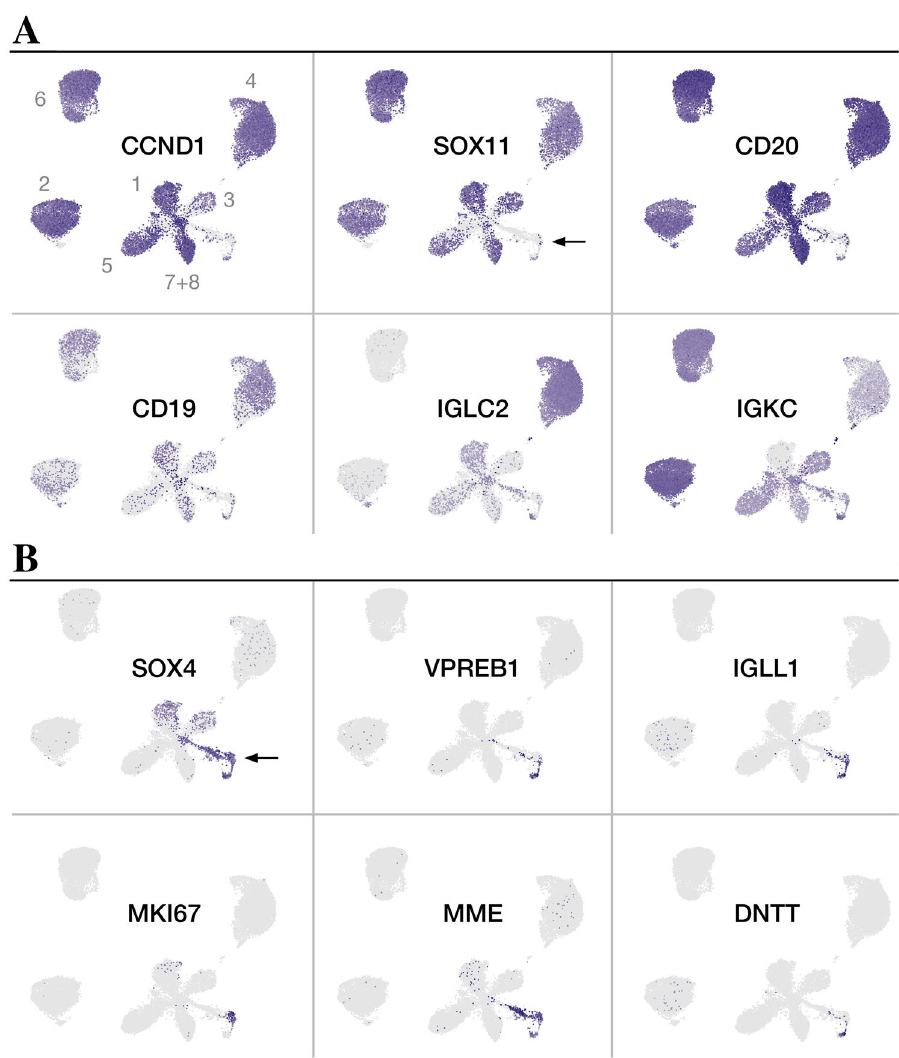
Figure 2. Global expression of molecular pathology markers frequently applied in diagnosis of mantle cell lymphoma ( A ) and markers associated with immature B cells ( B ) in combined mantle cell lymphoma (MCL) single cell transcriptomes. The resolved representations of cells from each MCL patient (pt.) were in general agreement with molecular pathology markers of MCL ( A ), although CD19 was only positive in a fraction of the single cells at the transcriptional level (12.2%). The dominating Ig κ and λ light chain restriction could be transcriptionally identified, with pt. 2, 3, 5, 6, 7, 8 being κ, and 1 and 4 being λ, the average double-positive was 7%, ranging from 0 (pt. 1) to 24% (pt. 4). CCND1 and CD20 were the most widely expressed molecular pathology markers. Markers of immature pre-pro B cells and pro-B cells were expressed in SOX11 - areas containing cells from multiple patients ( B ). Three patients (pt. 1, 3 and 7) had a substantial cell fraction expressing SOX4 co-localized with SOX11 + . Purple indicates positive expression, and the intensity of the color reflects increased expression. MME: also known as